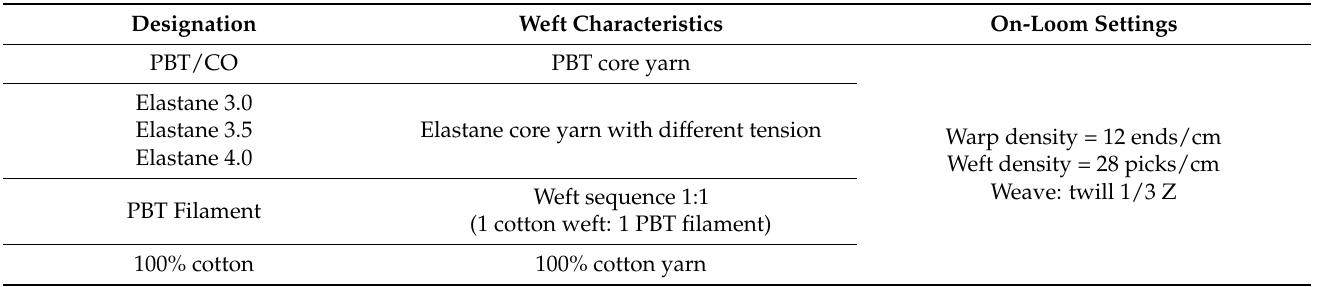
Table A1. Properties of terry samples before (b.t.) and after (a.t.) treatment.